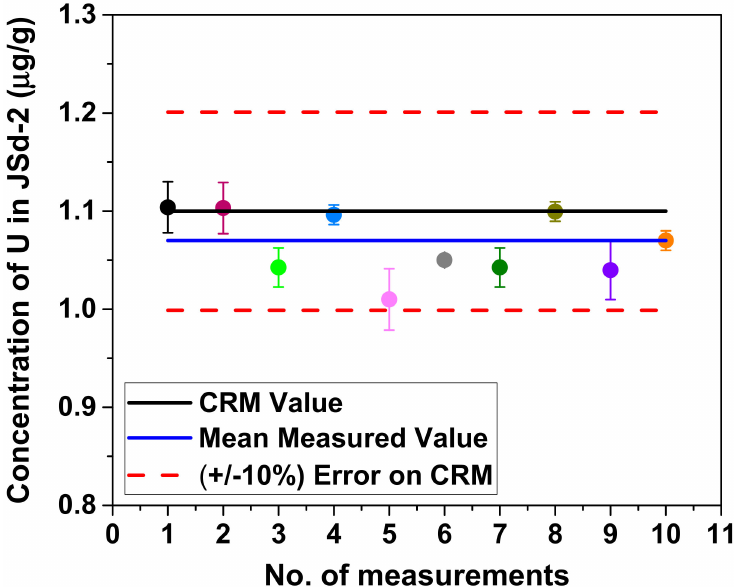
Figure 2. Measured recovery on 10 days for U in JSd-2 prepared by the Mw-4 method. (Errors in the method of analysis are represented as